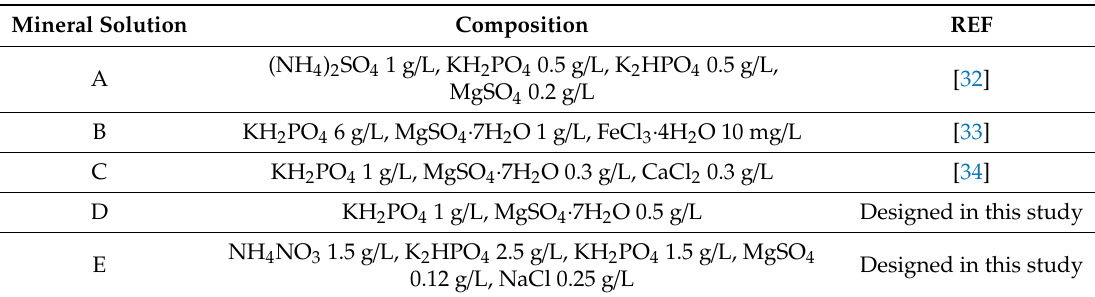
Table 2. Mineral composition investigated in